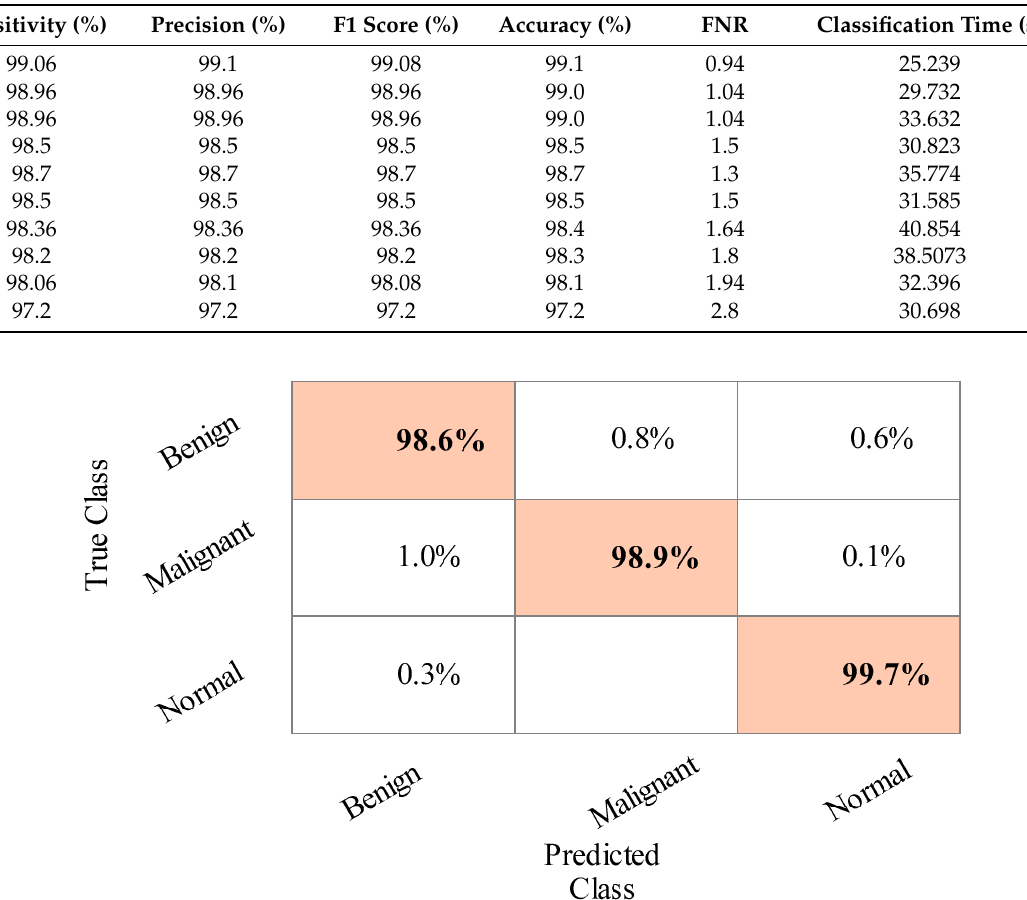
Table 6. Classification results of binary gray wolf optimization selector using ultrasound images, where the training/testing ratio is 50:50.